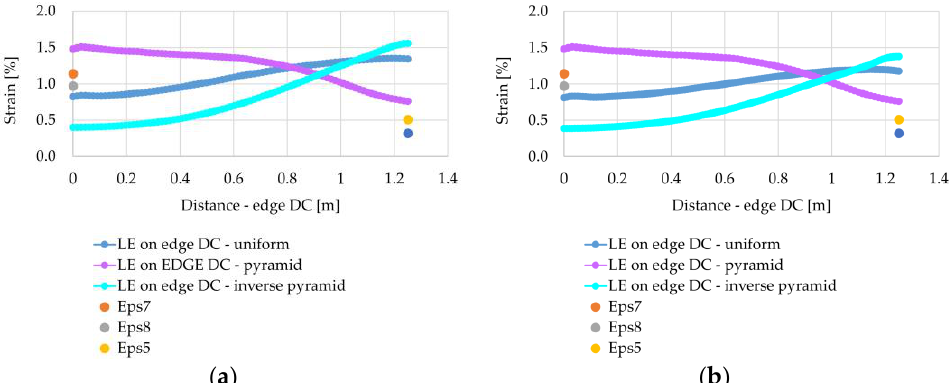
Figure 26. Comparison of the FEM calculation results for different load distributions with the results of strain measurements: ( a ) variant A1; ( b ) variant A2.